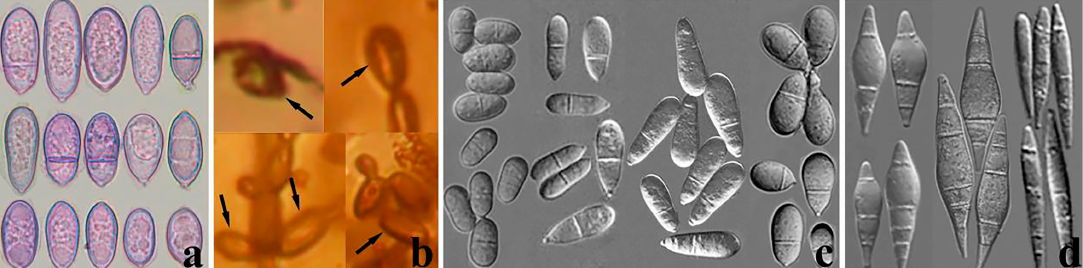
Figure 5. Conidia of several carnivorous fungi. ( a ) The single conidia formed by the separation of the blastospore of Arthrobotrys blastospora ; ( b ) The single conidia produced by Palaeoanellus dimorphus , reprinted with permission from Ref. [24]. 2023, John Wiley and Sons; ( c ) The conidia produced by some Arthrobotrys species [31]; ( d ) The conidia produced by most of the Dactylellina species